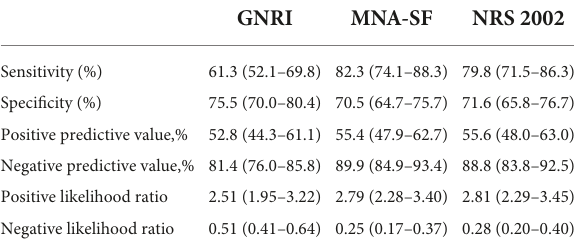
TABLE 4 Performance of three nutritional screening scales in the diagnosis of malnutrition in patients 65 years of age or older. GNRI